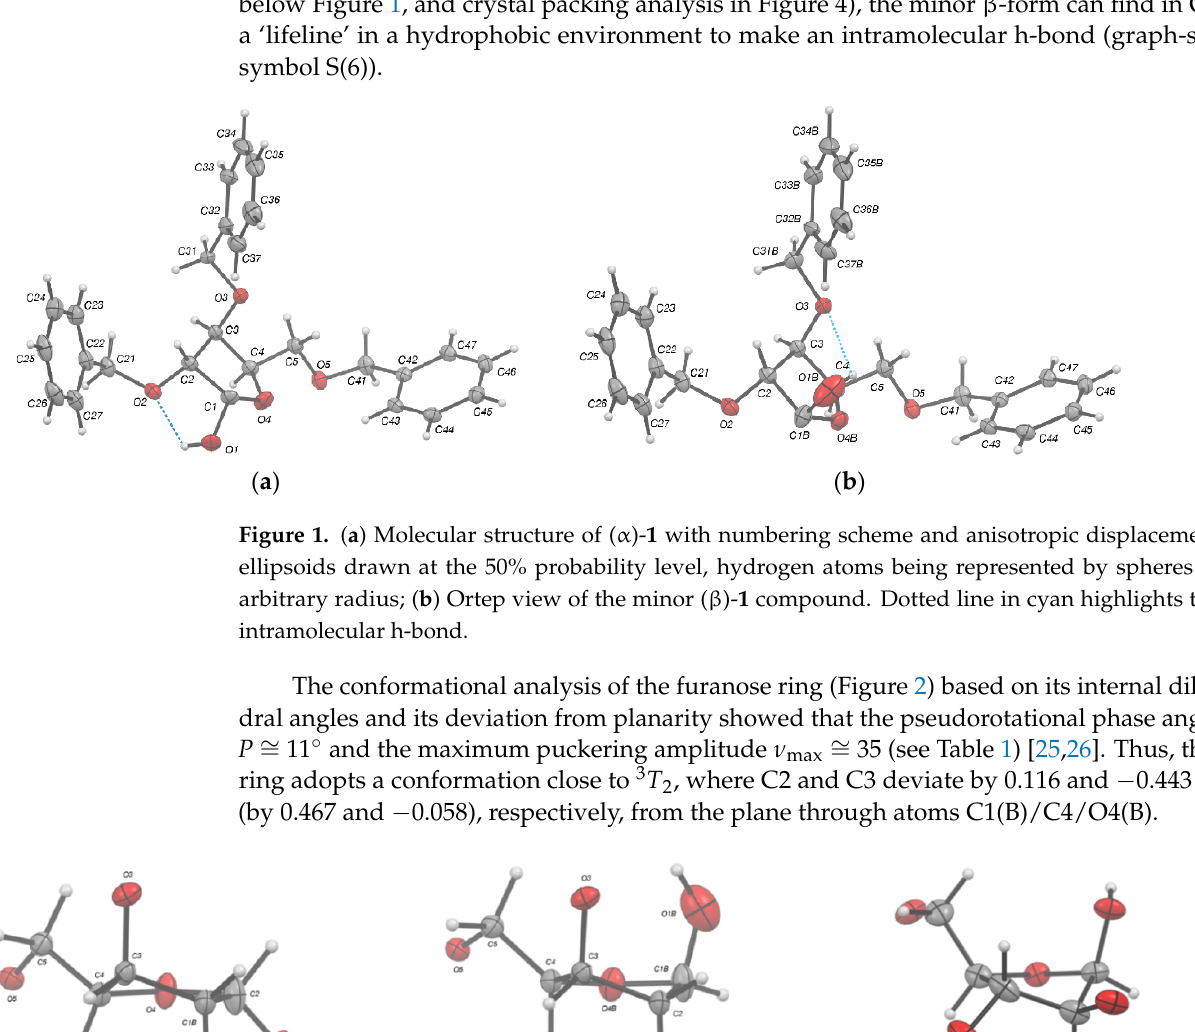
Figure 2. Close-up of the sugar ring puckering C3-endo, C2-exo (N-type) conformations for the ( a ) α form, and ( b ) β form. ( c ) Conformation of the 2,3,5- tri-O -benzyl- β - D -arabinofuranose analogue, depicted in the CCDC Refcode: LUHROX.